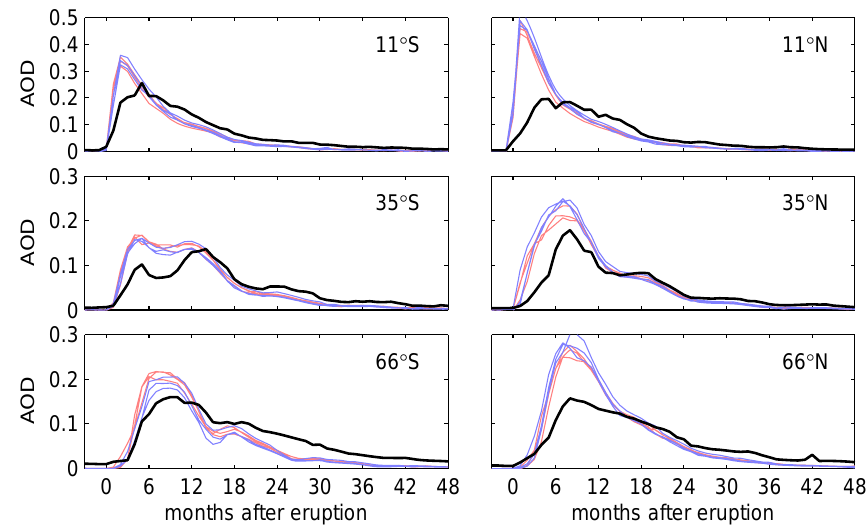
Fig. 1. Monthly-mean, zonal-mean 0.55µm AOD at labelled latitudes, from Pinatubo eruption period observations of the updated Sato et al. (1993) timeseries (black) and MAECHAM5-HAM Pinatubo-magnitude eruption simulations with eruptions at 15 ◦ N, 91 ◦ W (red) and 15 ◦ N, 120 ◦ E